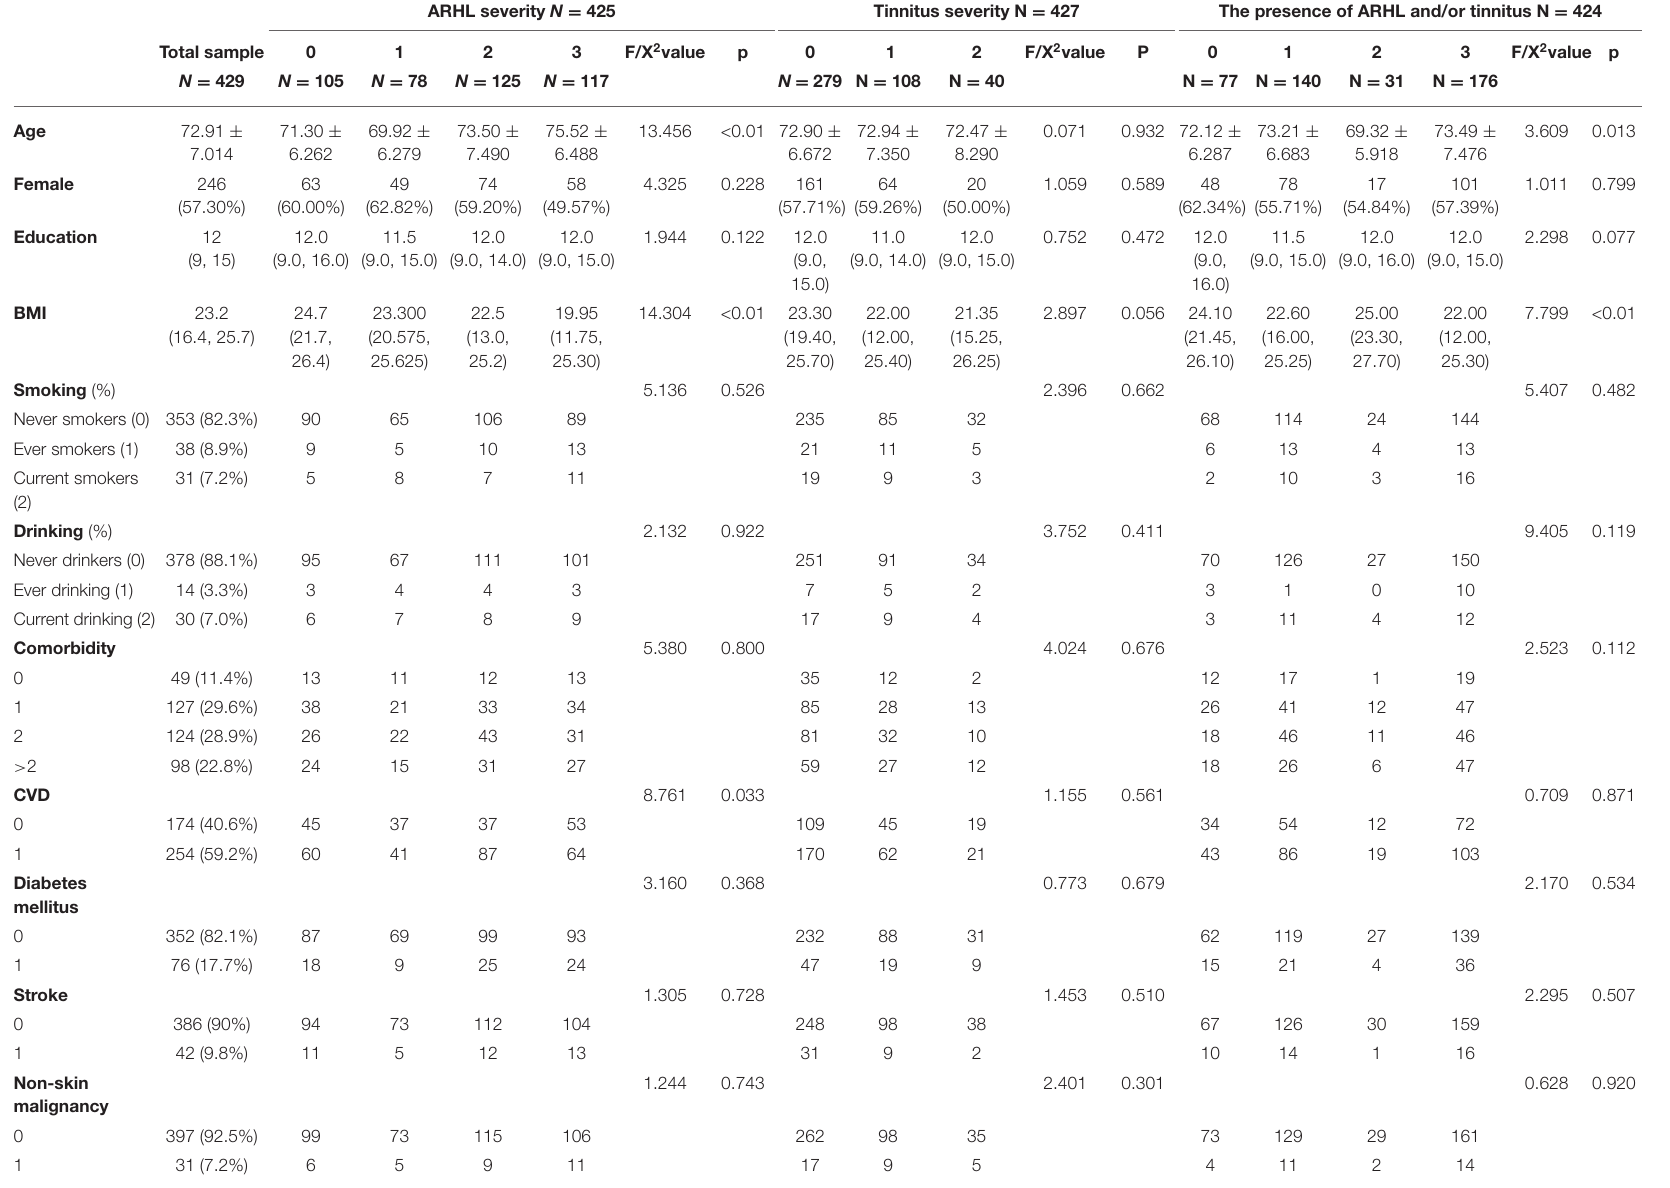
TABLE 1 | Participant characteristics by severity of ARHL and tinnitus and the presence of ARHL and/or tinnitus. ARHL severity N = 425 Tinnitus severity N = 427 The presence of ARHL and/or tinnitus N =